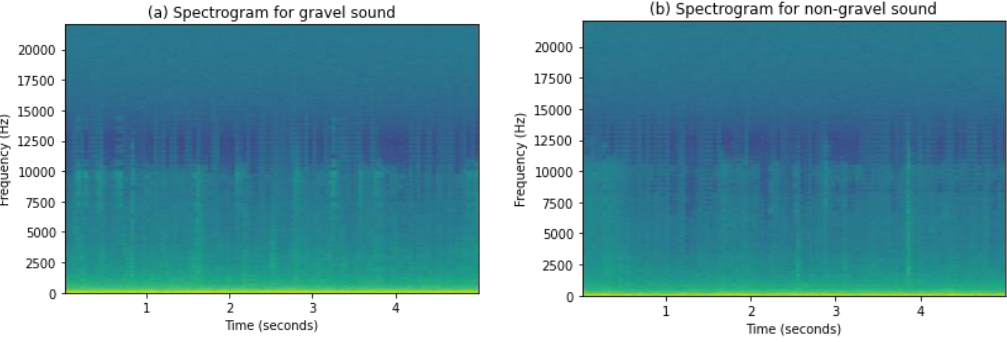
Figure 6. Spectrogram images of non-gravel and gravel sound. Neural networks (NN) are inspired by the human brain. A neural network comprises many artificial neurons containing weights and biases. These networks learn feature presentation, thus eliminating the process of manual feature selection process [63]. The training process involves backpropagation to minimize a loss of function, L = g ( x , y , θ ) through the tuning of parameters, θ . A loss function is calculated as the difference between observed and actual values. The cross-entropy loss function is often a choice in classification problems. The loss function is optimized iteratively through the calculation of the gradient descent by learning rate. The learning rate is an important parameter; it is the rate at which the gradients of each neuron are updated. A higher learning rate can reach the